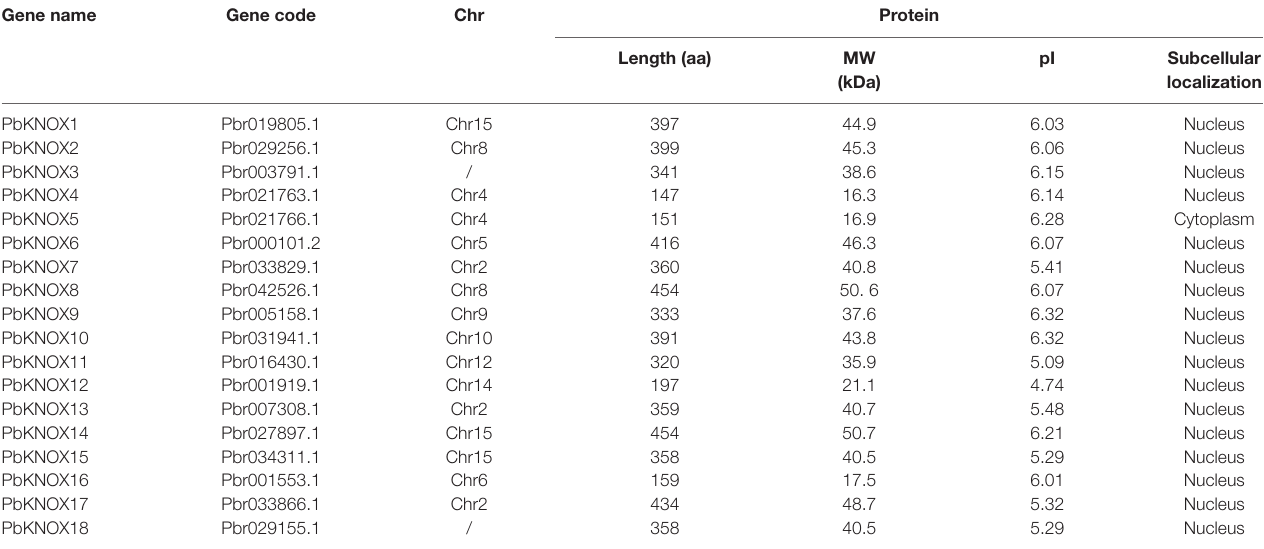
TABLE 1 | Sequence characteristics of 18 KNOX s identified in